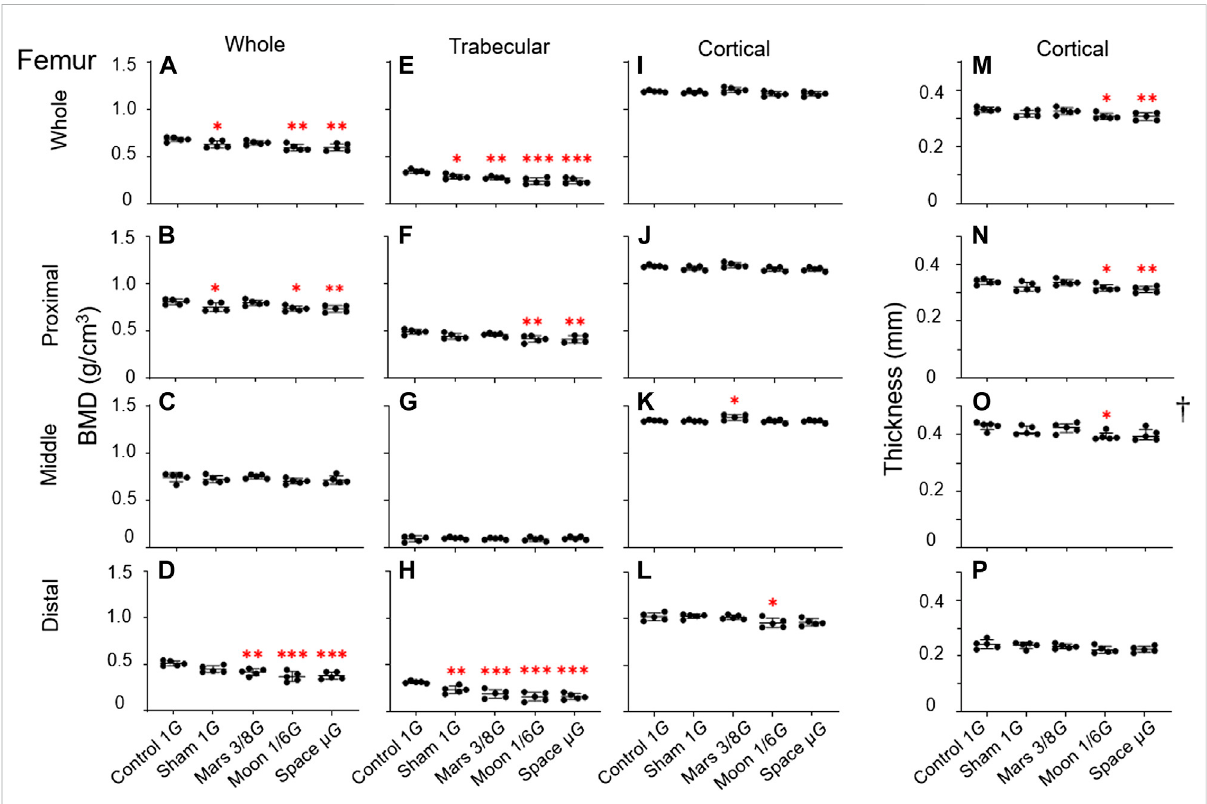
FIGURE 5 Bone parameters of various femoral regions compared among the fi ve experimental groups. (A – D) Overall BMD, (E – H) trabecular BMD, (I – L) corticalBMD,and (M – P) corticalbonethickness. (A,E,I,M) Wholefemur, (B,F,J,N) proximalfemur, (C,G,K,O) middlefemur,and (D,H,L,P) distalfemur [Mean ± SD, one-way analysis of variance; † M (P25, P75), kruskal-wallis test, n = 5. * p < 0.05 vs. control group, ** p < 0.01 vs. control group, *** p < 0.001 vs. control